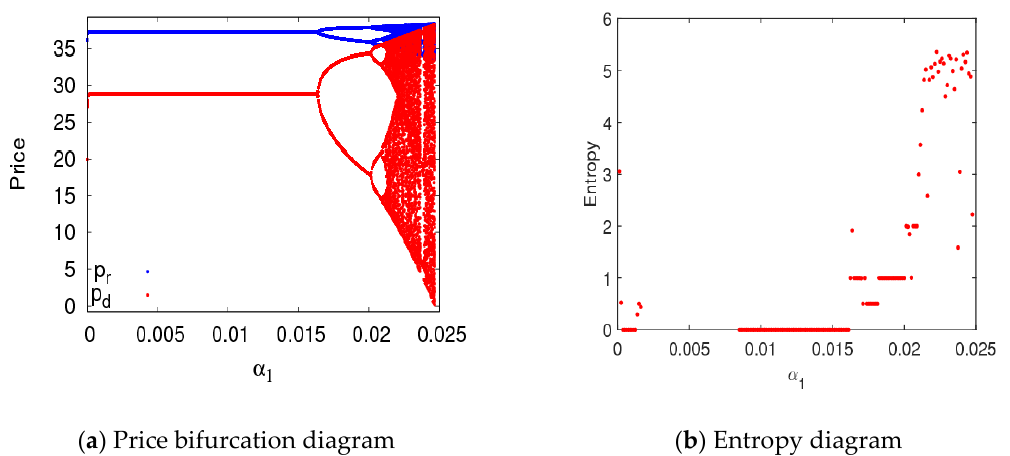
Figure 20. Bifurcation diagram and entropy of control System (11) with respect to 𝛼 1 when 𝑣 = 0.3.